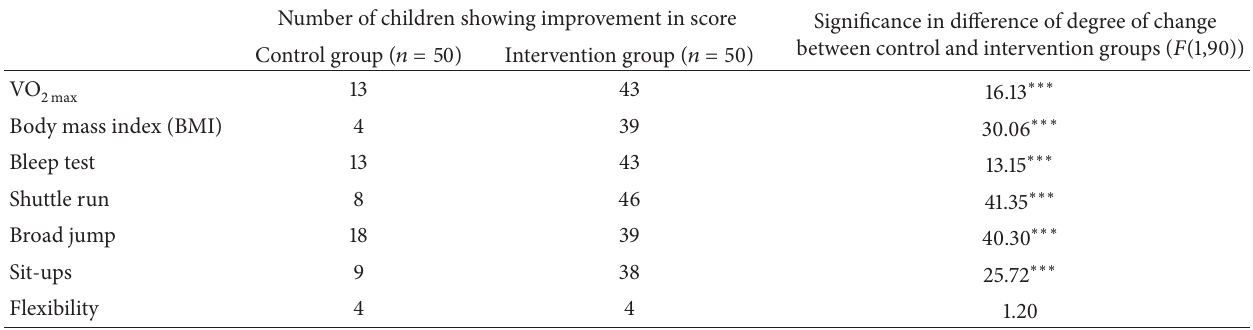
Table 4: Comparison of changes to fitness scores between the control and intervention groups ( 𝐹 calculated using ANCOVA with fixed factors of age and